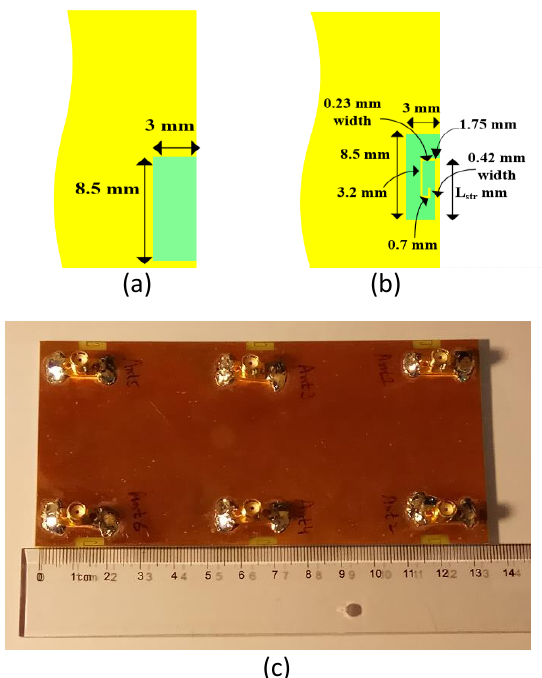
Figure 2. ( a ) The unit slot antenna Reference Antenna or Ref. Ant. ( b ) Proposed Antenna or Prop_Ant (Ant1). ( c ) Fabricated multiple antenna system.